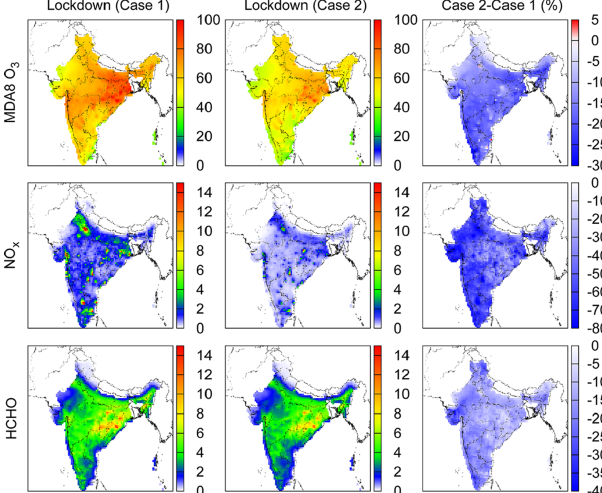
Figure 7. Predicted O 3 , NO x , HCHO, and the changes caused by nationwide lockdown measures from 24 March to 24 April 2020 in India. The unit is ppb. “Case 2 − Case 1” indicates (Case 2 − Case 1) / Case 1, reported as